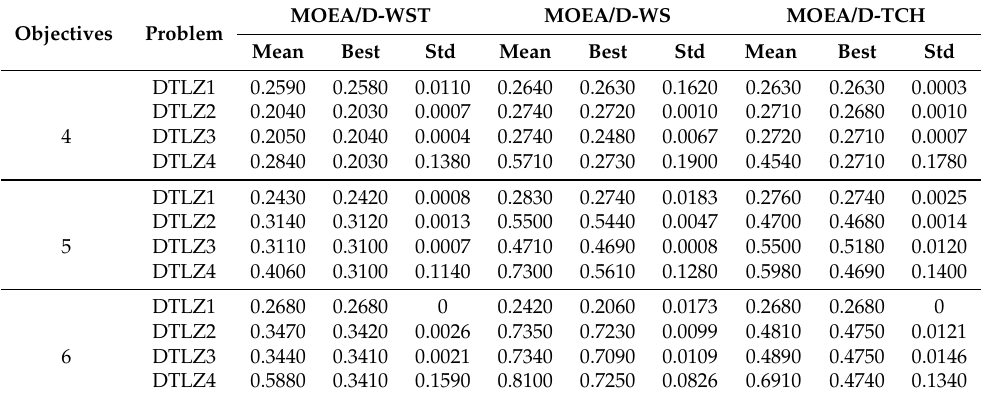
Table 2. Statistics of the IGD metric obtained by MOEA/D-WST, MOEA/D-WS and MOEA/D-TCH on DTLZ1–DTLZ4.